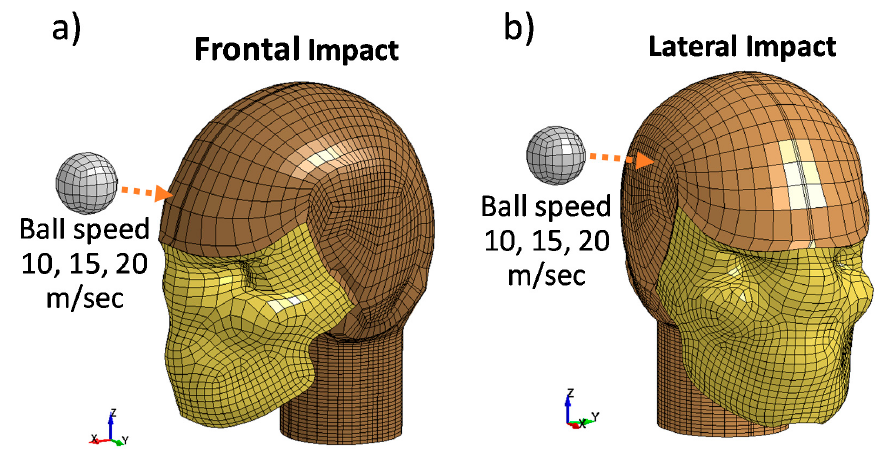
Figure 1. The finite element (FE) head model used in this study includes the main components of the human head [44].